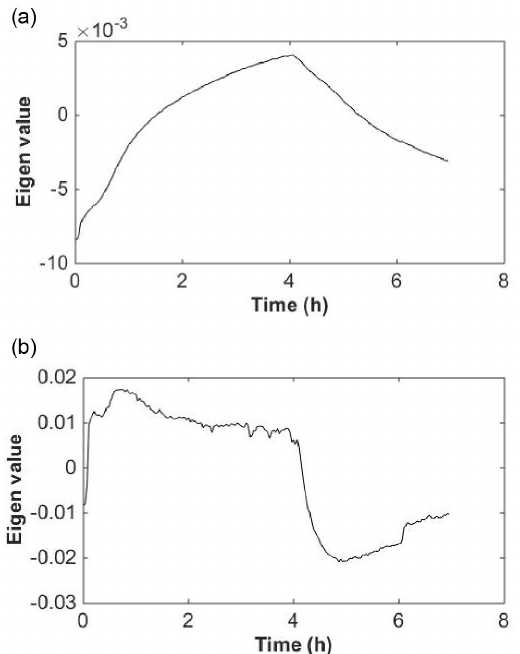
Figure 6. Data processing using Karthunen–Lo è ve Transform on Experiment III results: ( a ) first and ( b ) second eigenvector, which can be associated to thermal tracer breakthrough signal and heat losses signal along injection tube, respectively.